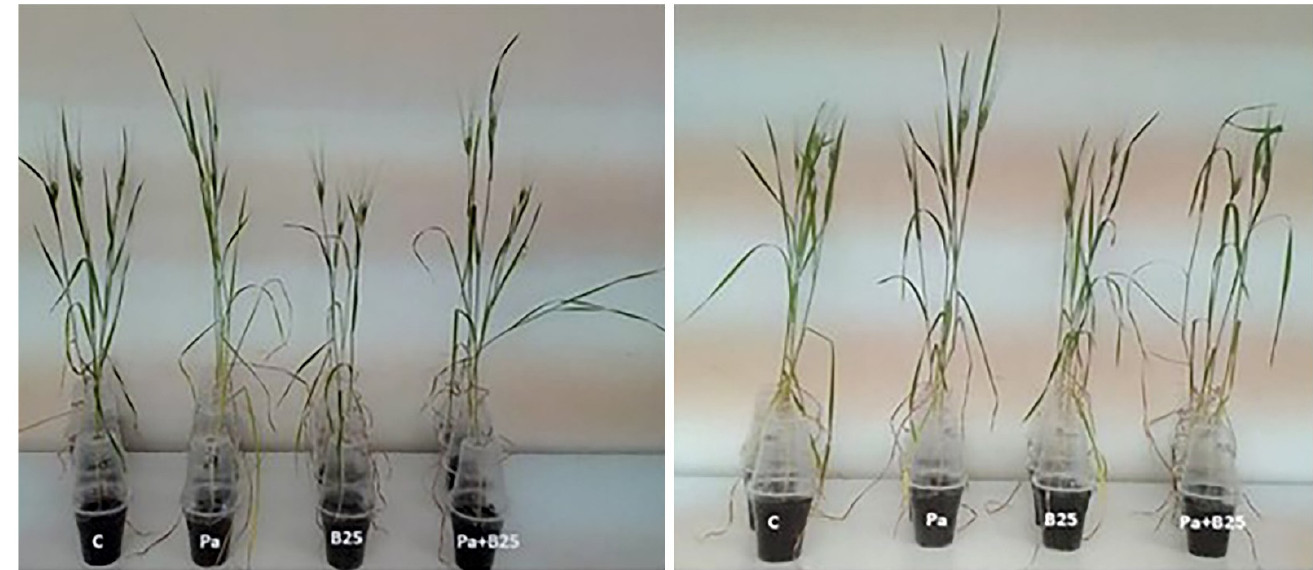
Figure 4. Effect of bacterial inoculation on in vitro wheat plants grown in sterile compost. ( Left ) Bousselam variety. ( Right ) Boutaleb variety.